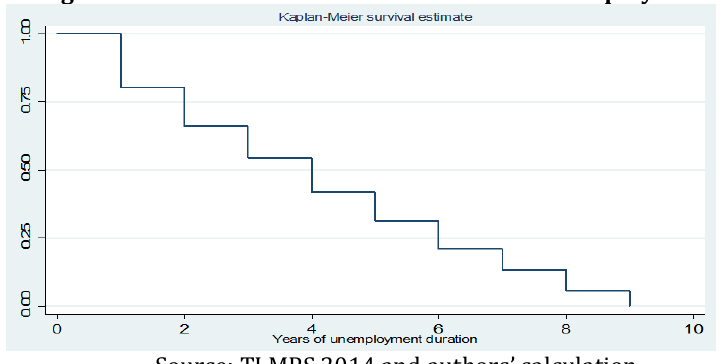
Figure 1: Survival function estimates for all unemployed